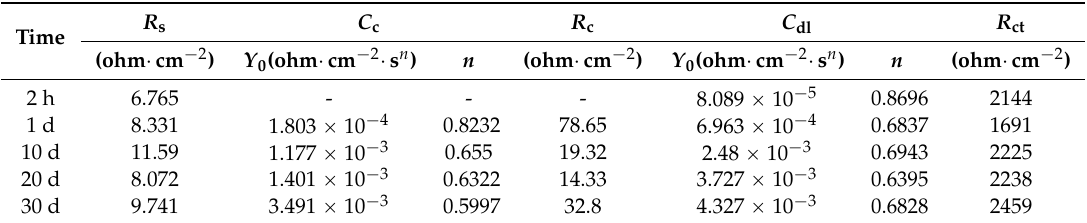
Figure 7. The Bode of the Ni 2 Al 3 coating in different soaking times. The symbols delegate the experimental results, and the lines delegate the model results. ( a ) Impedance diagram; ( b ) phase diagram. Table 2. EIS parameters for the Ni 2 Al 3 coating at different immersion